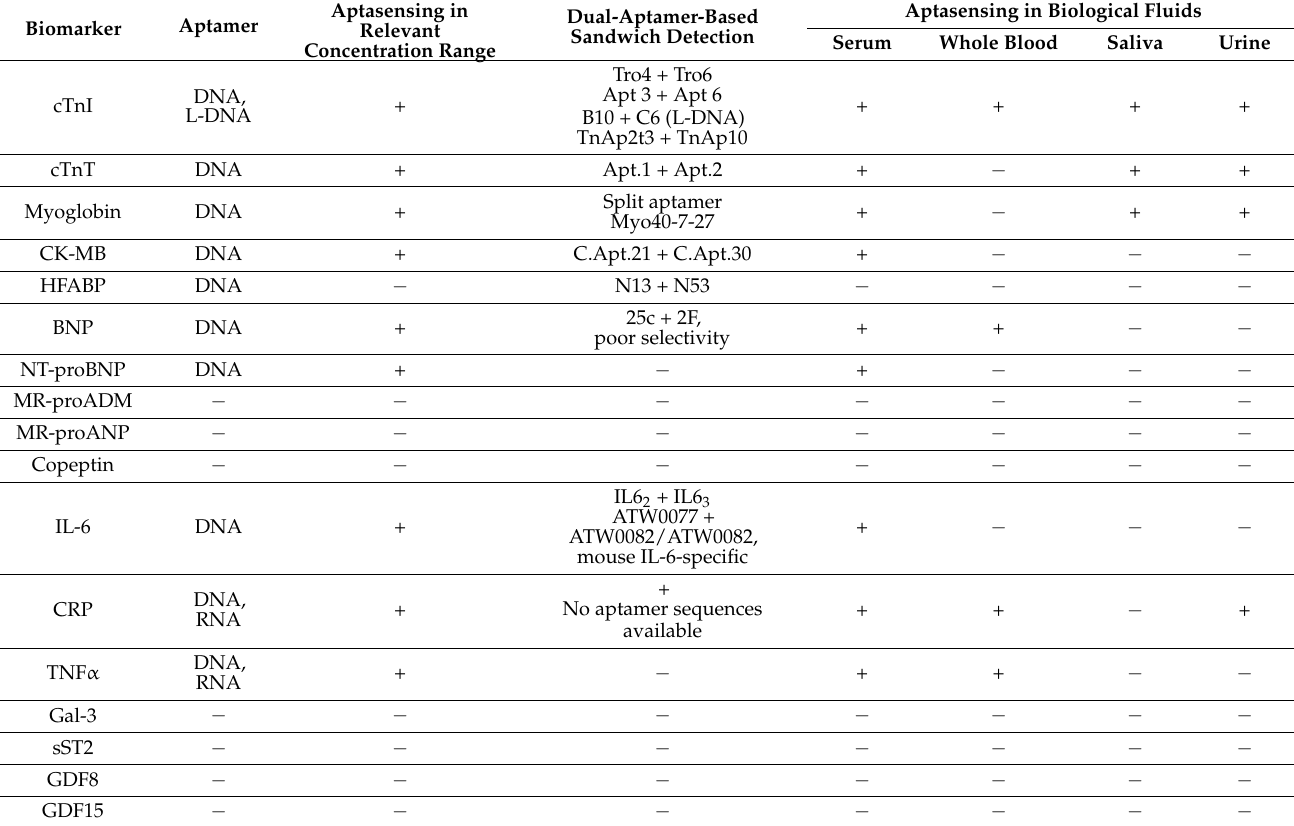
Table 2. Summary of aptamer-based detection methods for the most common cardiac